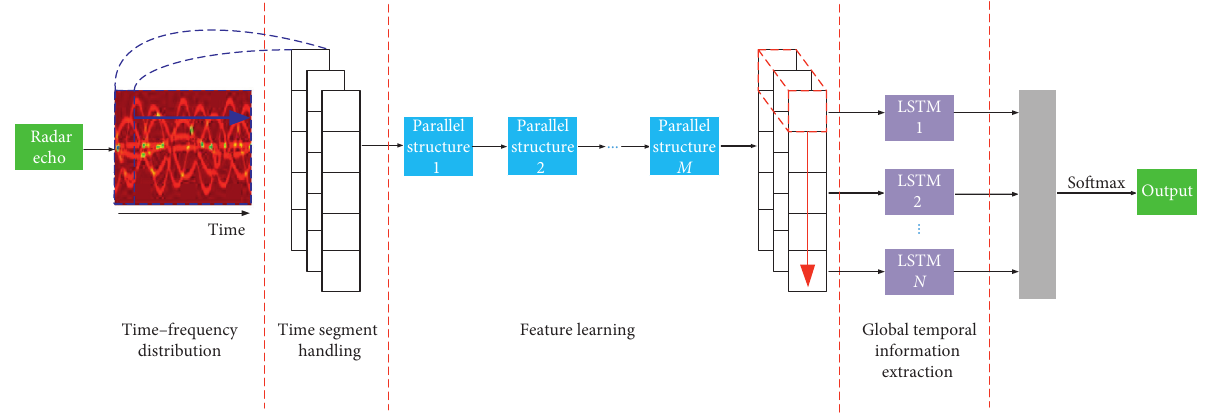
Figure 3: Schematic diagram of the proposed method.